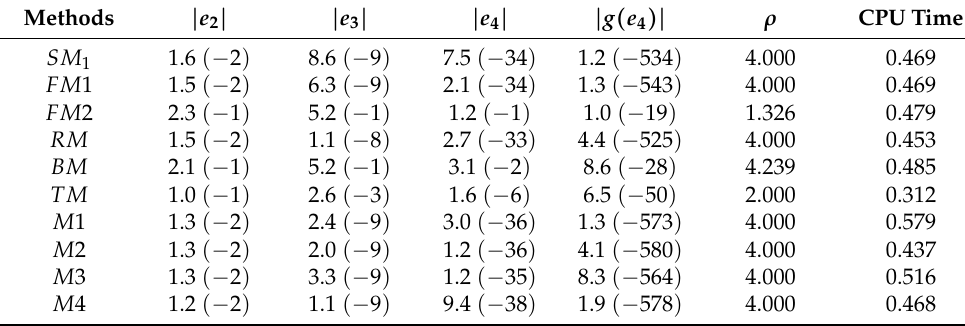
Table 7. The outcomes of Example 5 on various methods.